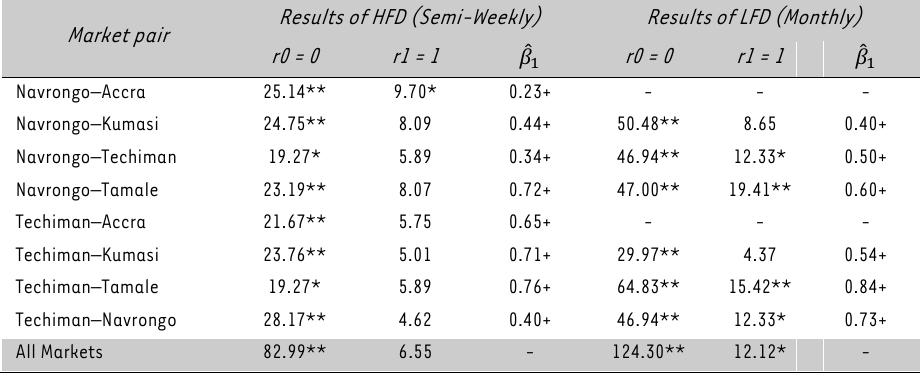
Johansen’s cointegration test statistics and long-run relations between market pairs Results of HFD Market pair